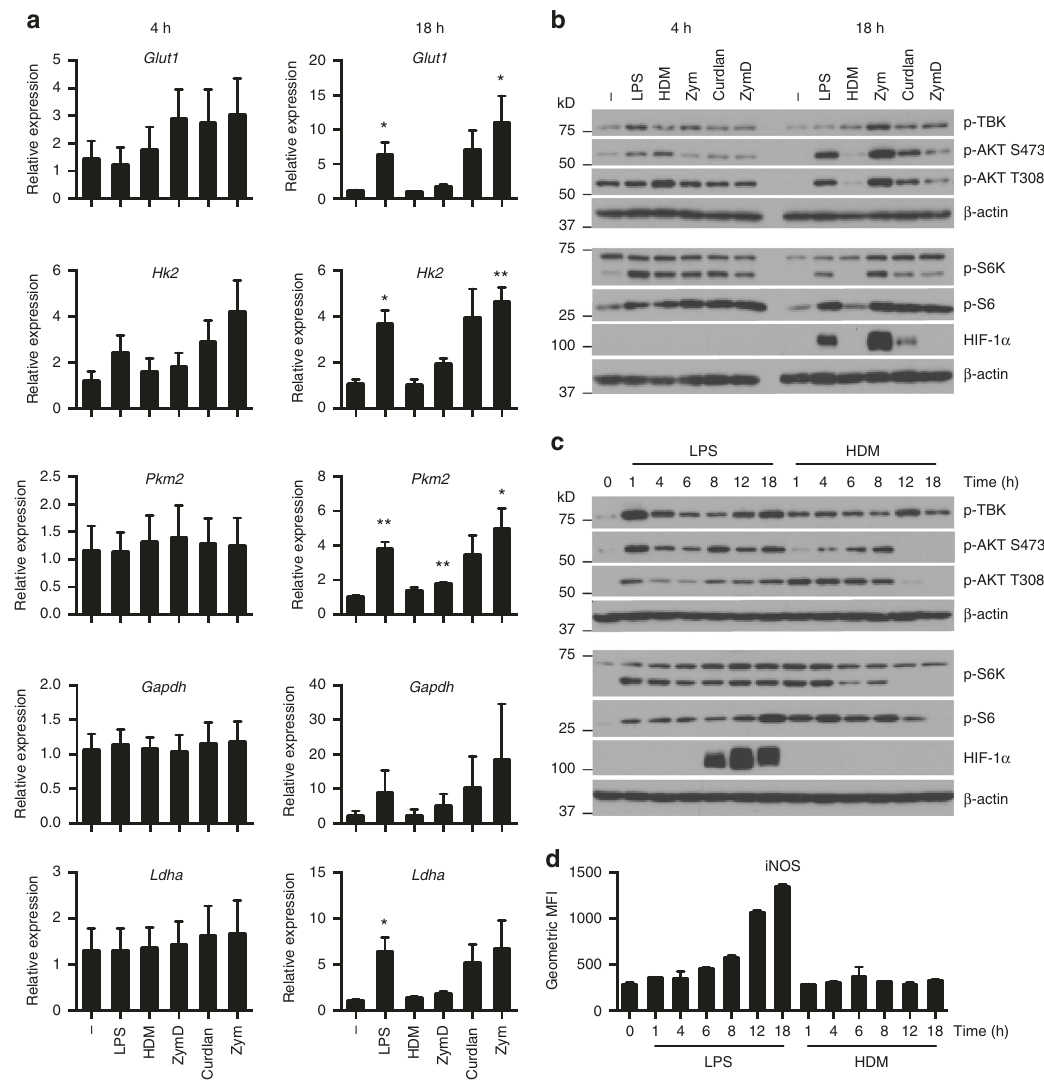
Fig. 4 Weakly activated DCs lack long-term metabolic reprogramming. a Gene expression of glucose transporter Glut1 and glycolytic enzymes Hk2, Pkm2, Gapdh , and Ldha by DCs were measured after differential activation for 4 h (left) and 18 h (right). b , c Immunoblot for p-AKT (Ser473), p-AKT (Thr308), p- TBK (Ser172), p-S6K, p-S6, HIF-1 α , and β -actin following ( b ) differential activation for 4 and 18 h, and ( c ) activation by LPS or HDM over a time course from 1 to 18 h. d Geometric MFI of iNOS in DCs activated by LPS or HDM over a time course from 1 to 18 h. Data shown in a are fold changes from three experiments, b , c one experiment representative of three experiments, and d one experiment representative of two experiments (mean and s.e.m. ( a ) and s.d. ( d ) of triplicates). Data were analyzed using t -test, comparing each condition relative to the control. ** p < 0.01, * p <